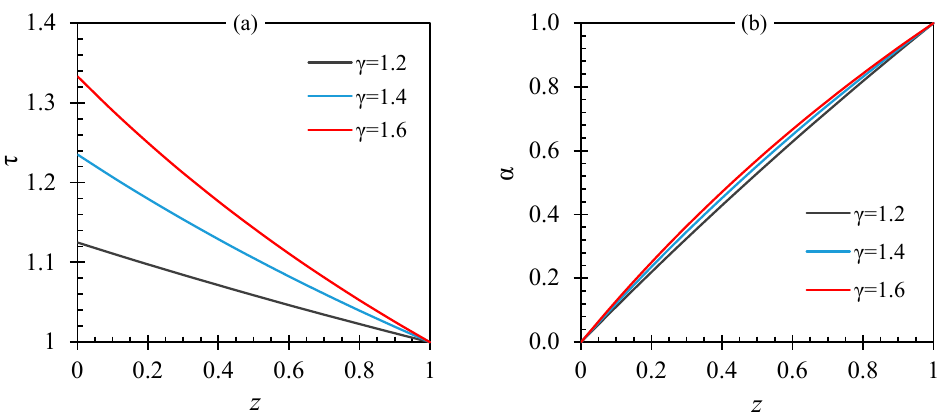
Figure 4. Dimensionless temperature of the driving gas at the end of the compression stroke ( a ) and relative efficiency ( b ) for different heat capacity ratios as a function of the relative work; r = 3.